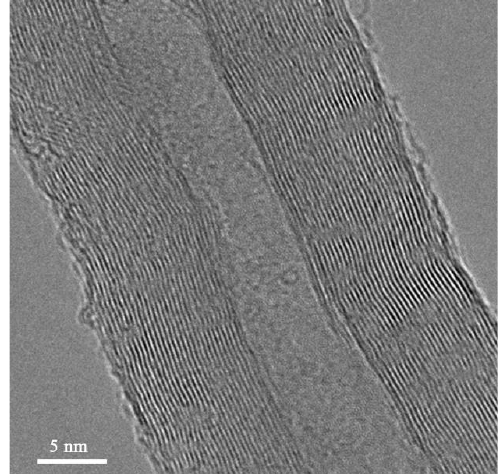
Figure 2. HRTEM image of CNTs/alumina CVD hybrid compound.